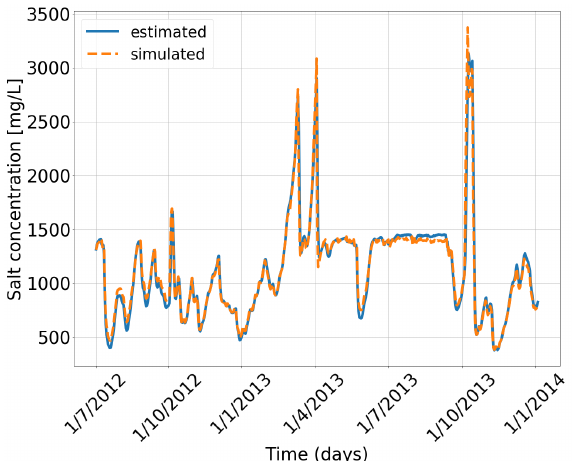
Figure 11. Performance of the sensor placement at node 445.